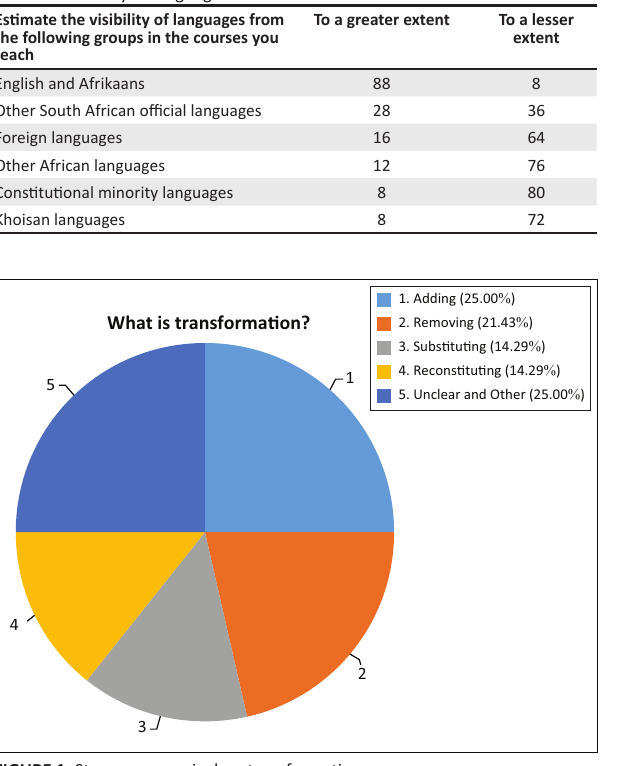
FIGURE 1: Stances on curriculum